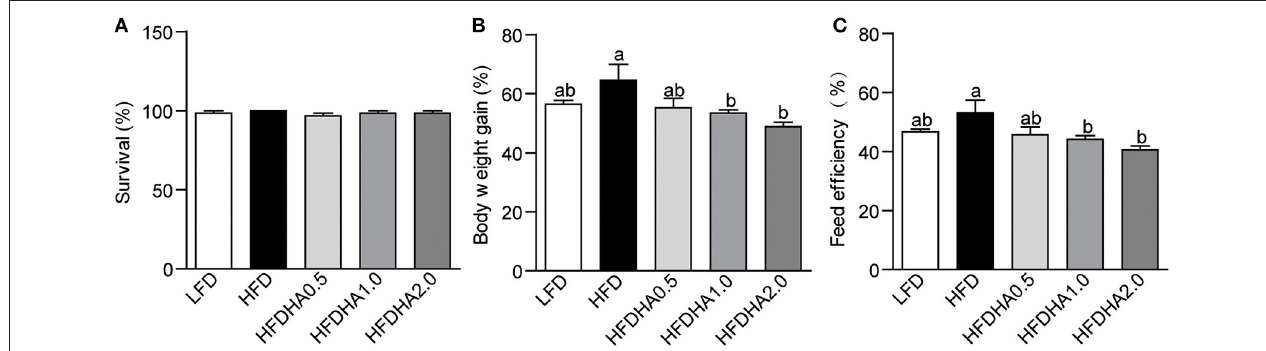
FIGURE 1 | Effects of DHA supplementation on (A) Survival, (B) body weight, (C) feed efficiency. Values are means ± SEMs ( n = 3 biological replicates). Means without a common letter are significantly different, P < 0.05.